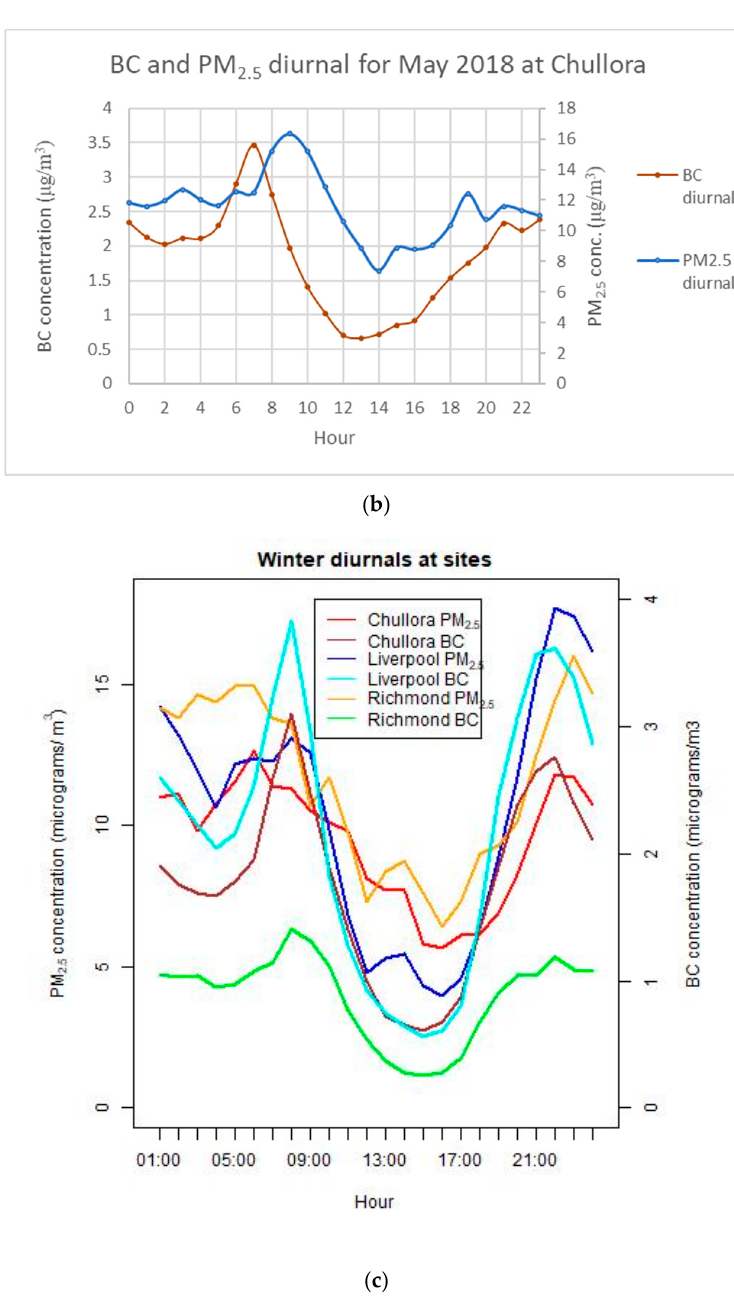
Figure 7. ( a ) Hourly BC/PM 2.5 ratio at Chullora with average decrease from about 20% to 15% during May 2018 when many HRBs occurred outside Sydney; ( b ) BC and PM 2.5 average diurnal patterns during May 2018 at Chullora; and ( c ) BC and PM 2.5 diurnal pattern during winter period at Chullora, Liverpool and Richmond.